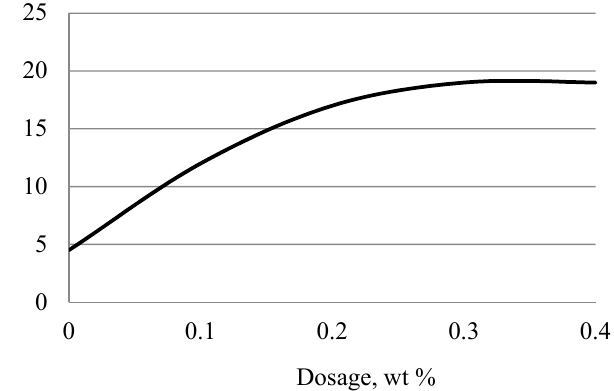
Figure 13. Dependence of the diameter of the mini-cone spreading on the dosage of 1,3,5-trihydroxybenzene-2-furaldehyde.